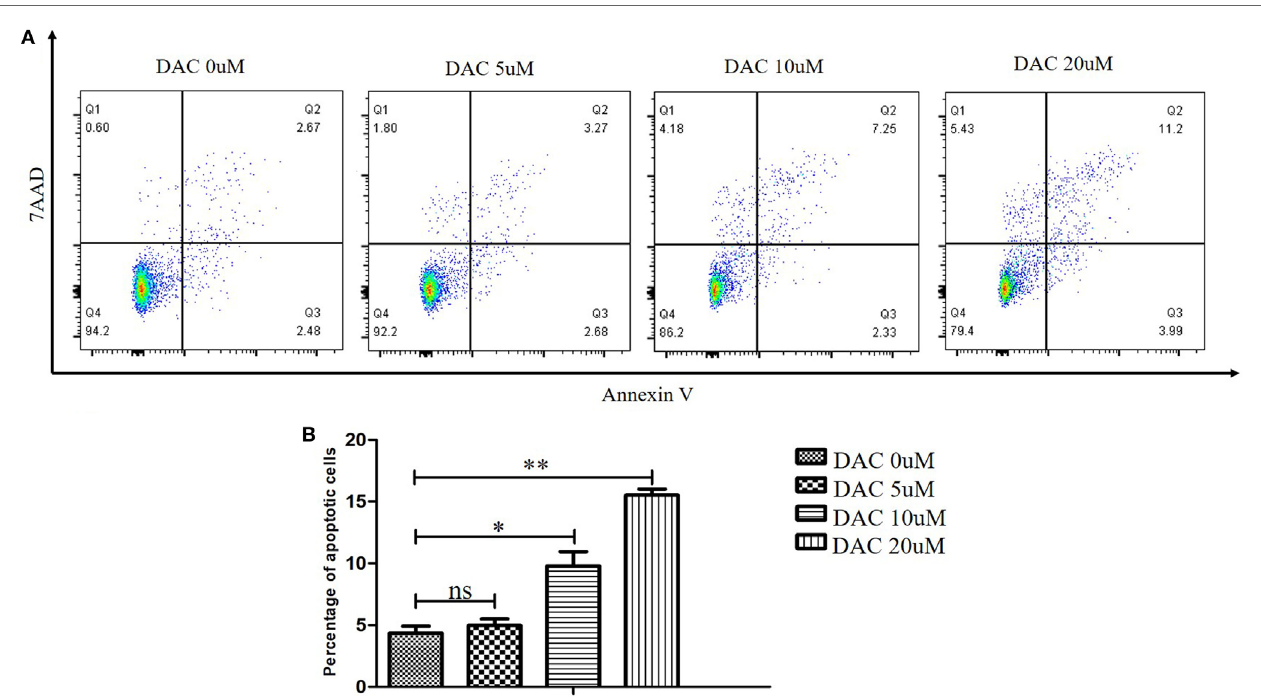
FigUre 1 | Effect of decitabine (DAC) on apoptosis in human γδ cells. DAC was added to γδ cell cultures at final concentrations ranging from 0 to 20 µM, or phosphate-buffered saline as vehicle control for 3 days. Media containing DAC was replenished every day. (a) Cell apoptosis was analyzed by flow cytometry with annexin V-PE/7-amino-actinomycin D (7-AAD). (B) The apoptotic rate was shown for three separate experiments. Error bars show SD among the replicates (* P < 0.05; ** P <